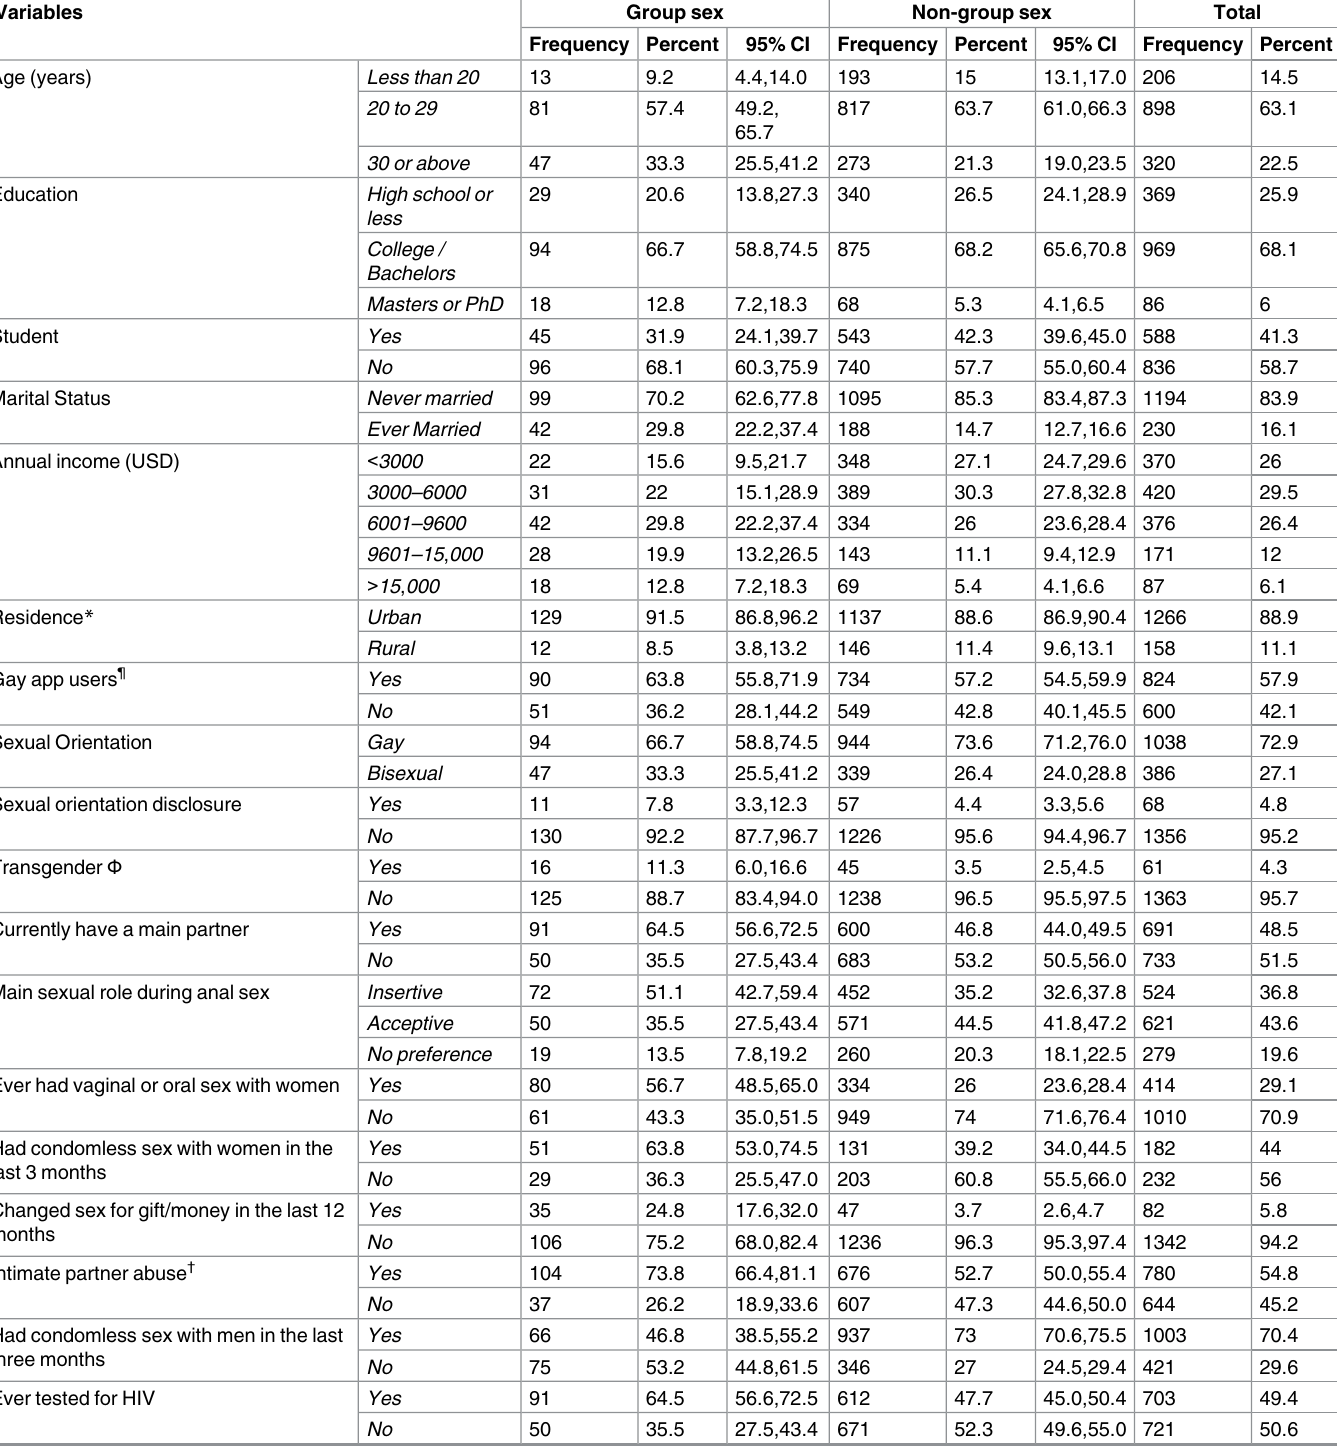
Table 1. Socio-demographic characters and behaviors among Chinese MSM who engaged and not engaged in group sex, 2014 (n = 1424).